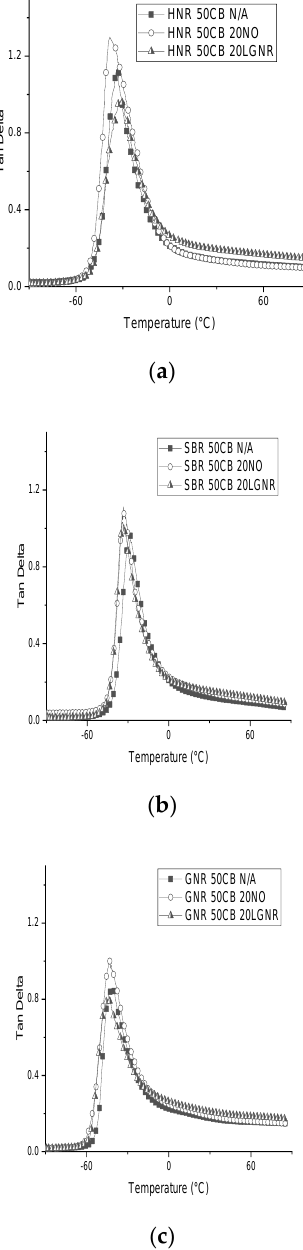
Figure 11. The tan δ of rubber composites made with or without processing aids from − 90 ◦ C to 90 ◦ C: ( a ) Hevea natural rubber (HNR); ( b ) styrene butadiene rubber (SBR); ( c ) guayule natural rubber (GNR) composites. N/A: rubber compounds without processing aids; 20 NO: rubber compounds with 20 phr naphthenic oil; 20 LGNR: rubber compounds with 20 phr liquid guayule natural